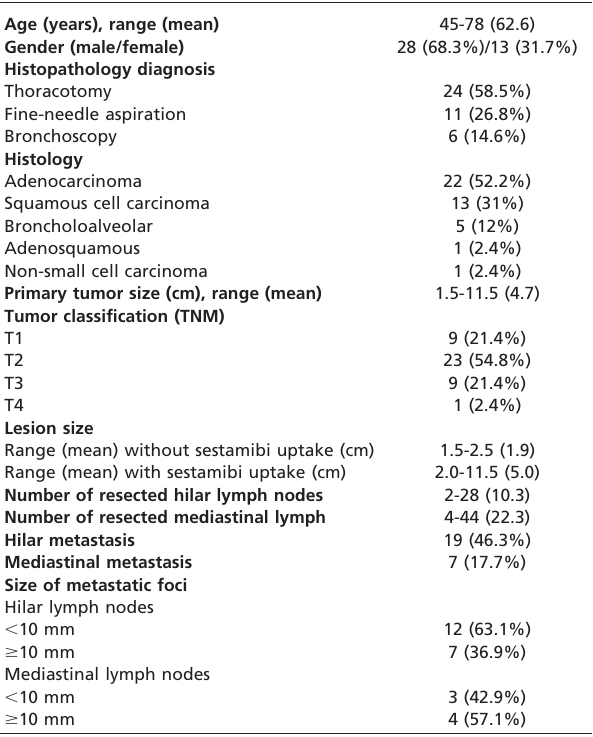
Table 1 - Patient characteristics (n=